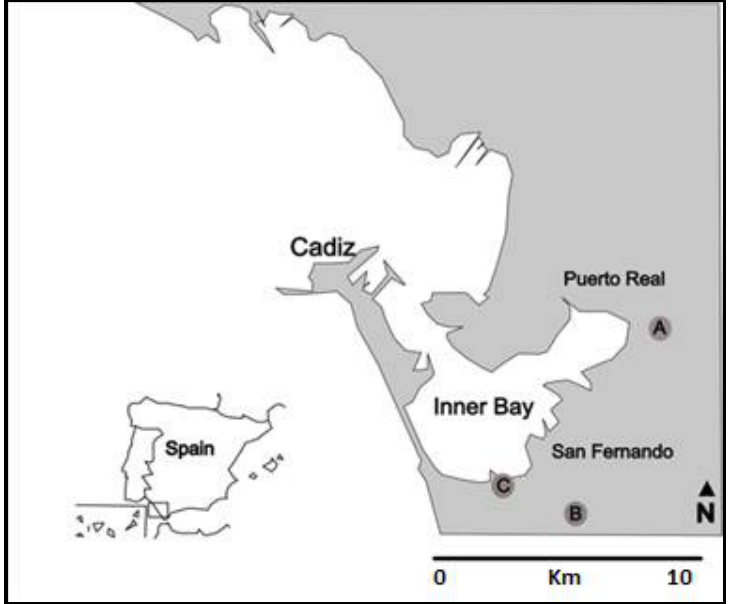
Figure 1. Collection sites in the inner Cadiz bay: (A) Salina La Esperanza (36°30′42″ N 6°09′10″ W), where in situ cultures were also carried out, (B) El Carrascon (36°27′00″ N 6°12’13″ W) and (C) Salina tres amigos (36°27′28″ N 6°13′49″ W).